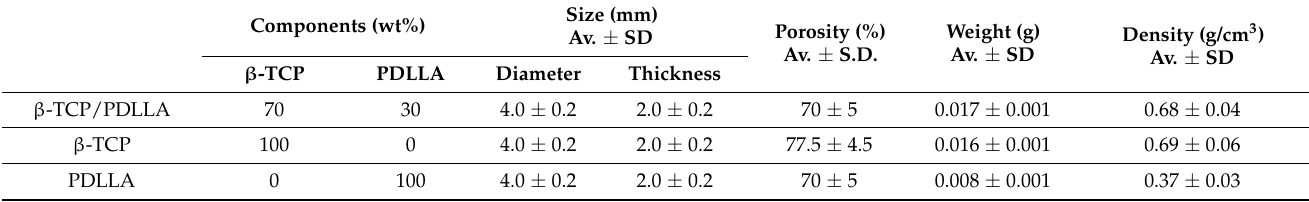
Figure 1. Stereomicroscopy and scanning electron microscopy images (×30 and ×100 magnification) of β -tricalcium phosphate/u-HA/poly- D / L -lactide ( β -TCP/PDLLA), β -TCP, and PDLLA. Table 1. Chemical and physical information of the biomaterials.